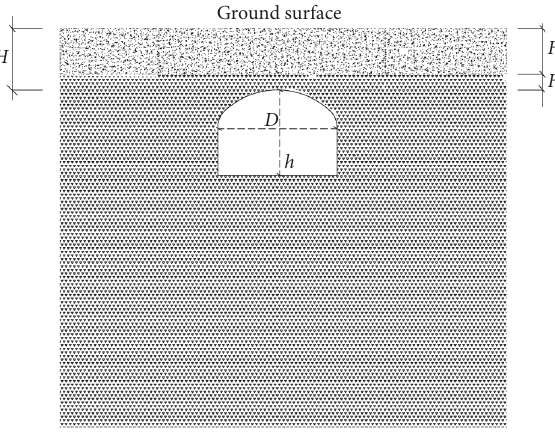
Figure 2: Analysis